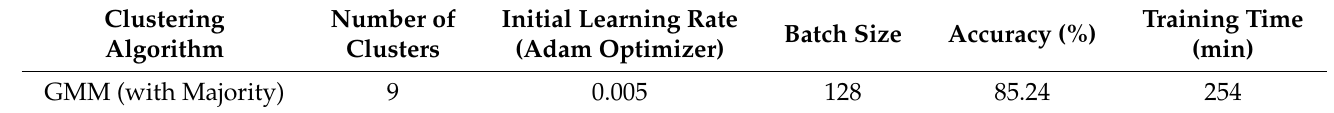
Table 6. Results of the majority